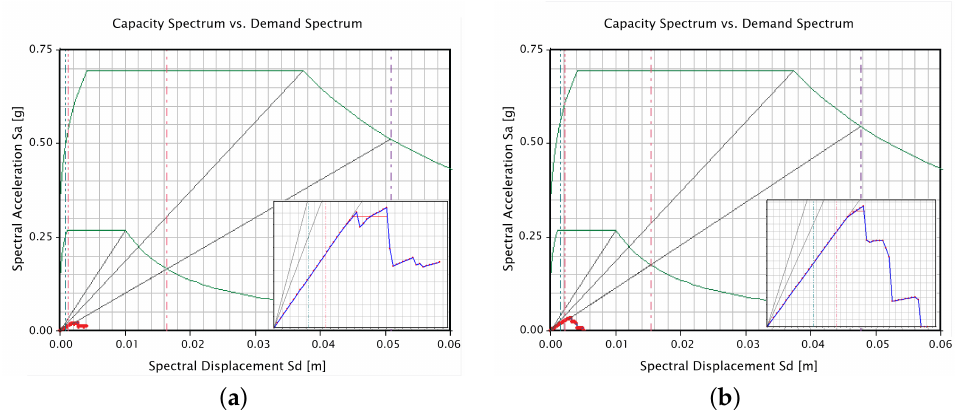
Figure 14. Seismic capacity and seismic demand curves for the SDOF equivalent system of the central wing. Displacements in the abscissae are in meters, and accelerations in the ordinates are in terms of gravitational acceleration, i.e., 1 corresponds to 9.8 m/s 2 . The inset shows a zoom of the capacity curve. ( a ) Seismic forces in direction X. ( b ) Seismic forces in direction Y.